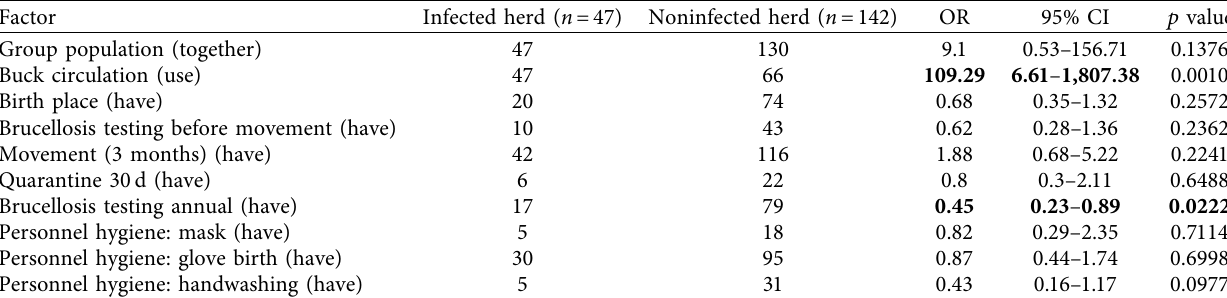
Table 2: Univariate analysis of risk factors for bacterial infection-caused reproductive failures in smallholder goats herds in northeastern Thailand.